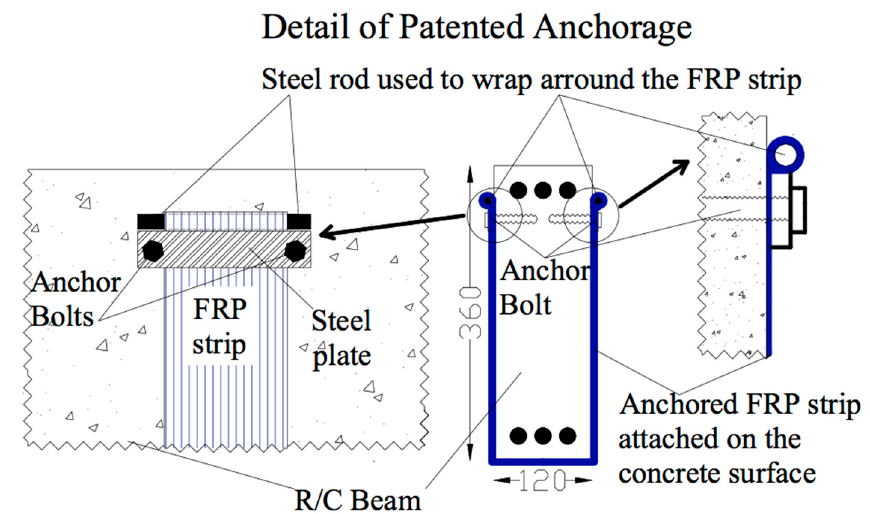
Figure 2. Arrangement of the patented anchoring device [EP2336455, 2011].